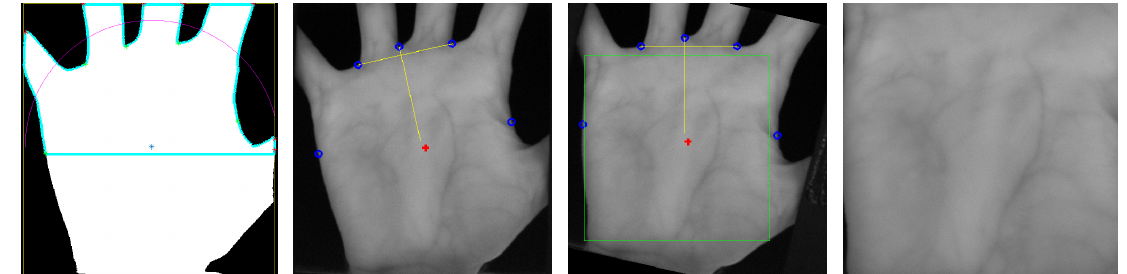
Figure 9. Hand vein ROI extraction process, from left to right: Segmented hand including outline and minima/maxima points, appropriate finger valleys and centre of mass selected, rotationally aligned hand image with maximum possible ROI fitted, final extracted